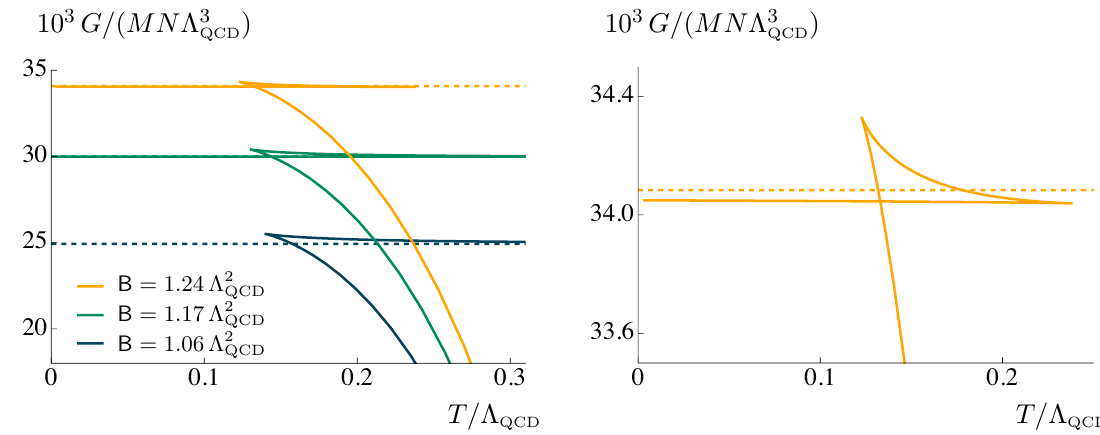
Figure 8. Left : free-energy density as a function of temperature for three different choices of magnetic field around B , both for plasma (solid curves) and confining (dashed straight lines) triple states. The lowest curve has B < B , the central one B ≈ B and the upper one B > B . triple triple triple Right : zoom in version of the upper curve, where it can be seen that above B the confining triple phase is disfavored. There is a first order phase transition between deconfined phases when the two solid lines